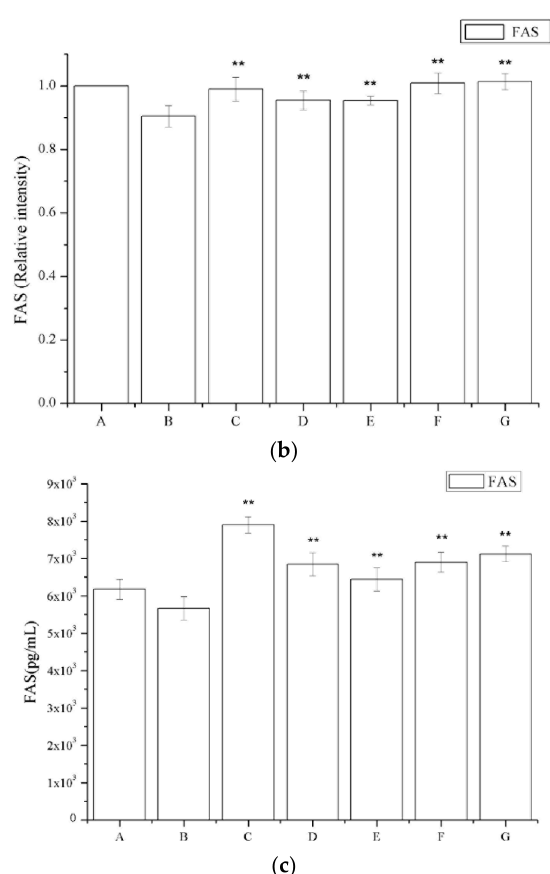
Figure 7. Effects of periostracum cicadae on FAS levels in the kidney. ( a ) representative immunohistochemistry image A: normal, healthy control group; B: IgAN model group; C: prednisone acetate group; D: tripterygium glycoside tablet group; E–G: treatment group that received 0.5, 1, and 2 g/kg periostracum cicadae; ( b ) the quantitative analysis of Fas protein in kidney tissues. Data represent the mean ± standard deviation (** p < 0.01 vs model group); ( c ) effects of periostracum cicadae on the levels of FAS in the tissue of IgAN rats (** p < 0.01).